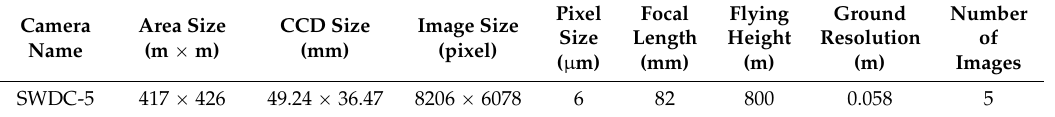
Table 2. The parameters of the photography from Yangjiang (aerial image captured at nadir). Camera